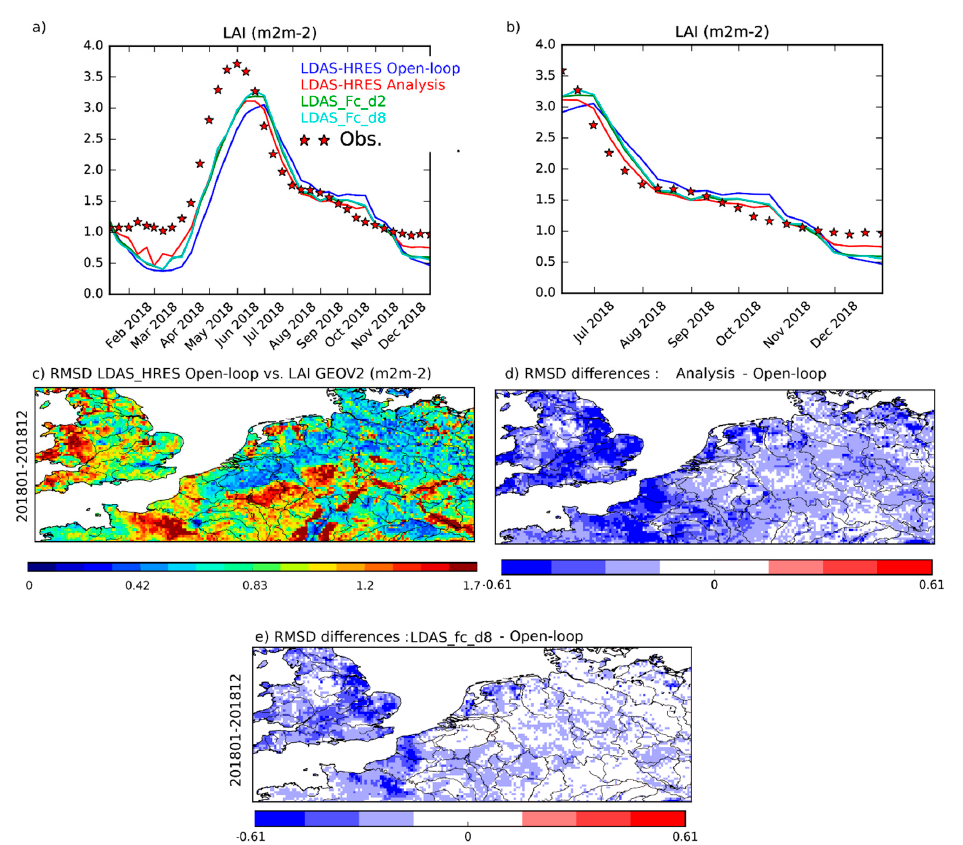
Figure 9. ( a ) LAI time series from the model (LDAS-HRES Open-loop in blue), the analysis (LDAS-HRES Analysis in red), the 2-d and 8-d forecasts from the analysis (LDAS_Fc_d2 in green, LDAS_Fc_d8 in cyan respectively) as well as the observations from the Copernicus Global Land Service (LAI GEOV2, red stars) for 2018. ( b ) same as ( a ) focusing on the June–December period. ( c ) RMSD values between LDAS-HRES Open-loop ran over 2018 and LAI GEOV2, ( d ) RMSD differences between LDAS-HRES analysis (open-loop) and LAI GEOV2, ( e ) same as ( d ) for LDAS_fc_d8 and open-loop.